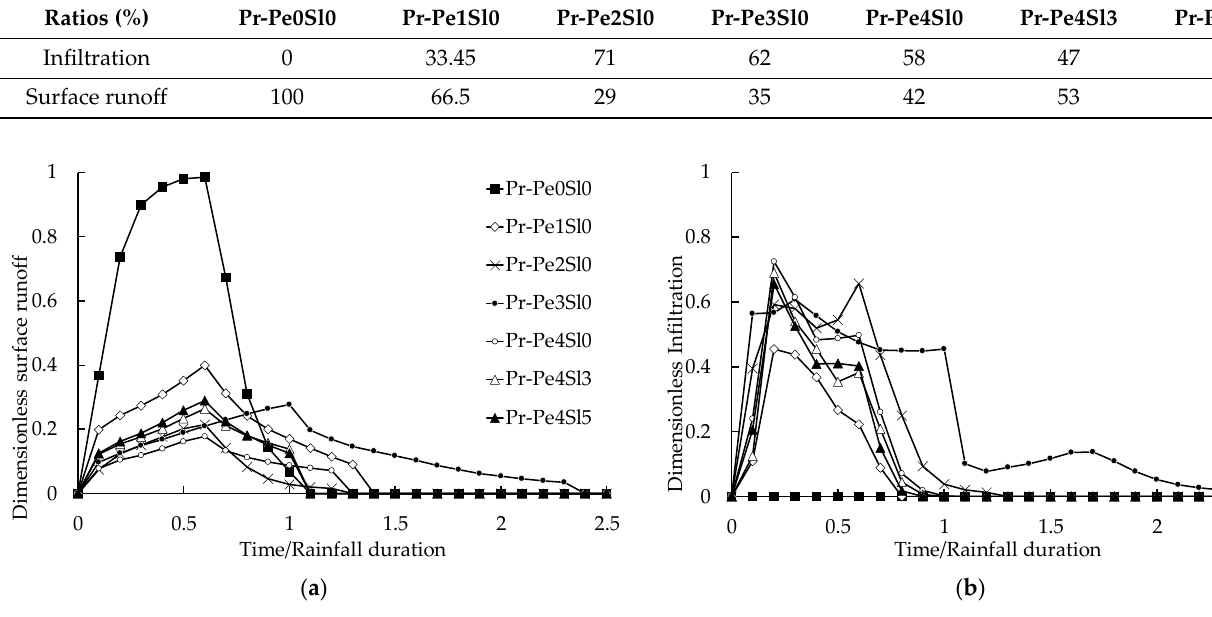
Figure 19. Results with various permeability: ( a ) infiltration; ( b ) surface runoff.